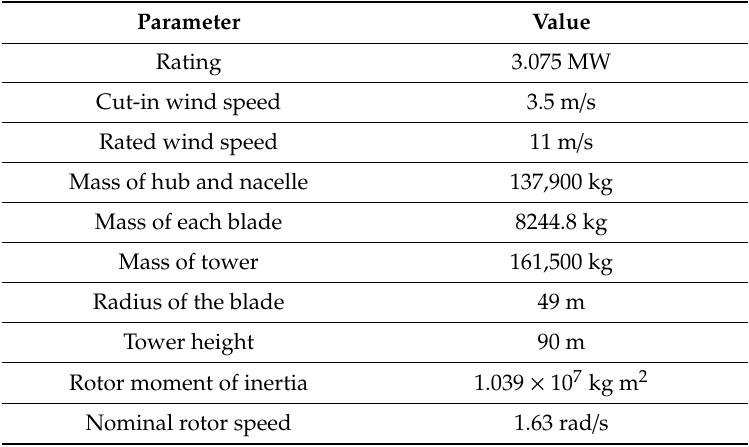
Table 5. Wind turbine parameters.